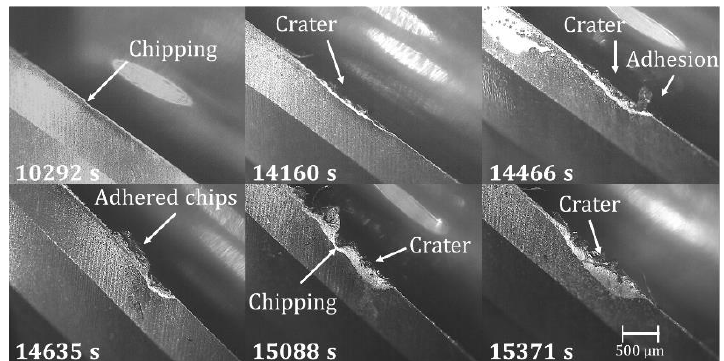
Figure 9. Growth of tool wear in EHDA-MQL environment against machining time.